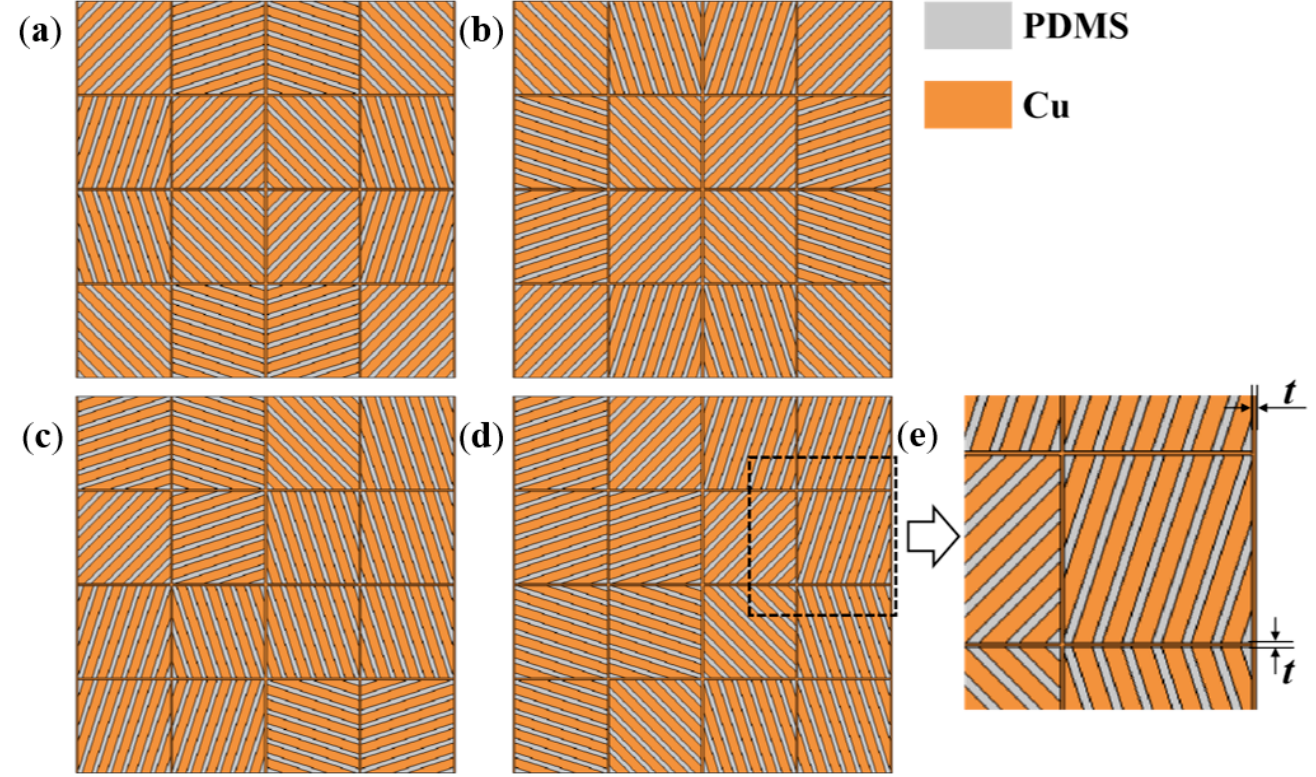
Figure 8. Sketches of the thermal meta ‐ structural devices constituted by three types of square unit modules, for the thermal manipulation functions of thermal cloak ( a ), thermal concentration ( b ), thermal rotation ( c ), and thermal dispersion ( d ), with a partially enlarged schematic diagram ( e ).